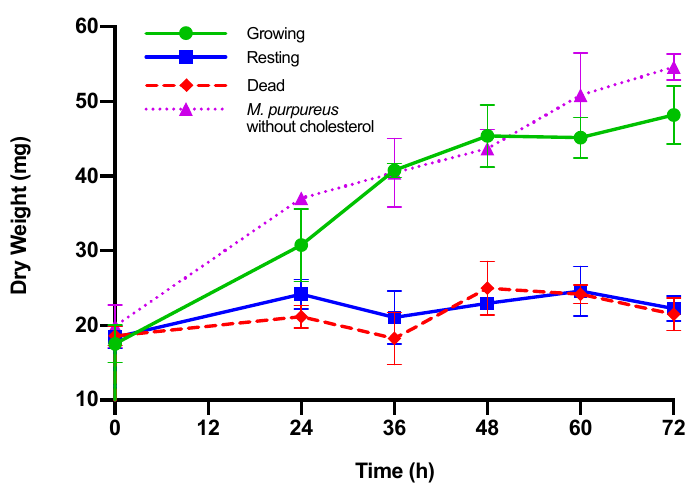
Figure 2. Dry weight of M. purpureus CBS 109.07. Growing, resting, or dead M. purpureus cultures were incubated in 120 µg/mL cholesterol and 0.3% ( w / v ) oxgall bile salts at 37 °C. M. purpureus incubated without cholesterol served as a control. Three independent trials were conducted for each growth phase at each time point. Standard deviation is represented by error bars.